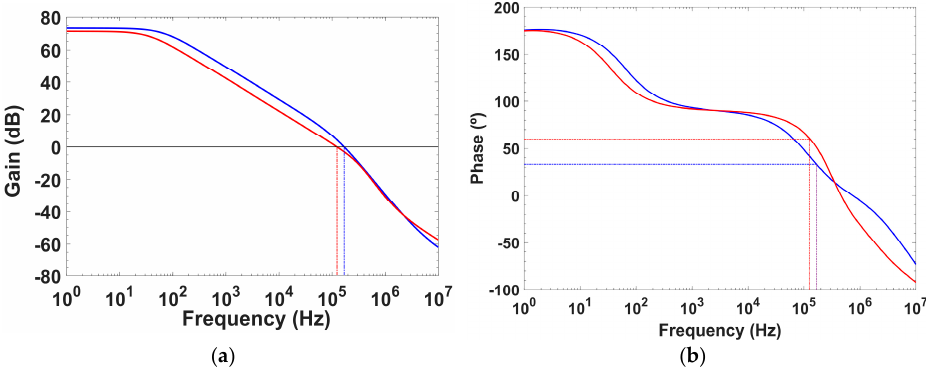
Figure 4. Simulated stability behavior with (red) and without (blue) cascode compensation for I L = 0, V BAT = 2.1 V: ( a ) gain; and ( b ) phase margin.